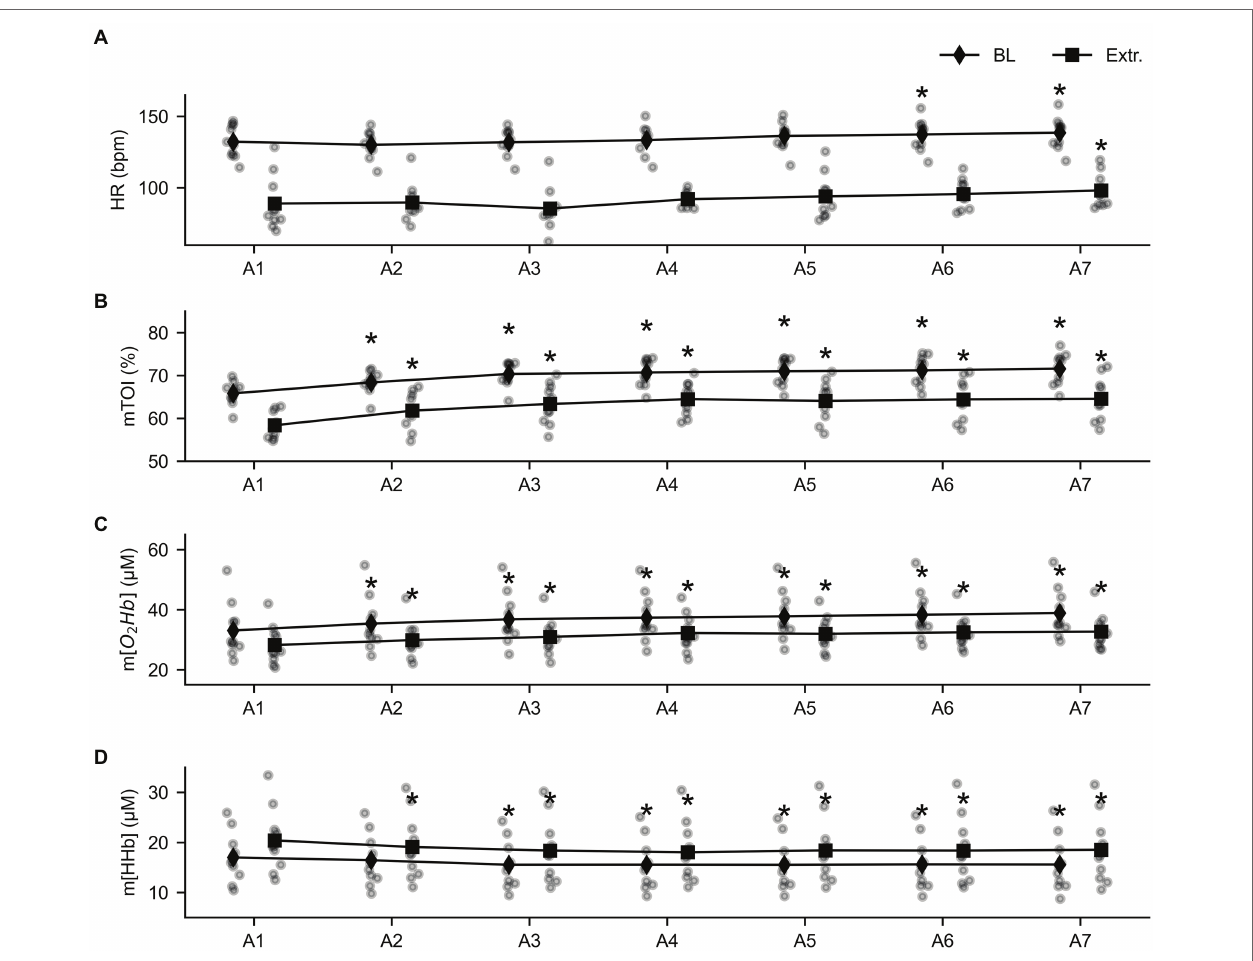
FIGURE 3 | Overview of the evolution of the baseline (diamond shapes) and extreme values (squares) throughout the series of seven apneas for heart rate (HR, panel A ), tissue oxygenation index (mTOI, panel B ), oxygenated (m[O 2 Hb], panel C ), and deoxygenated hemoglobin concentration (m[HHb], panel D ). * = statistically different from A1 at p <